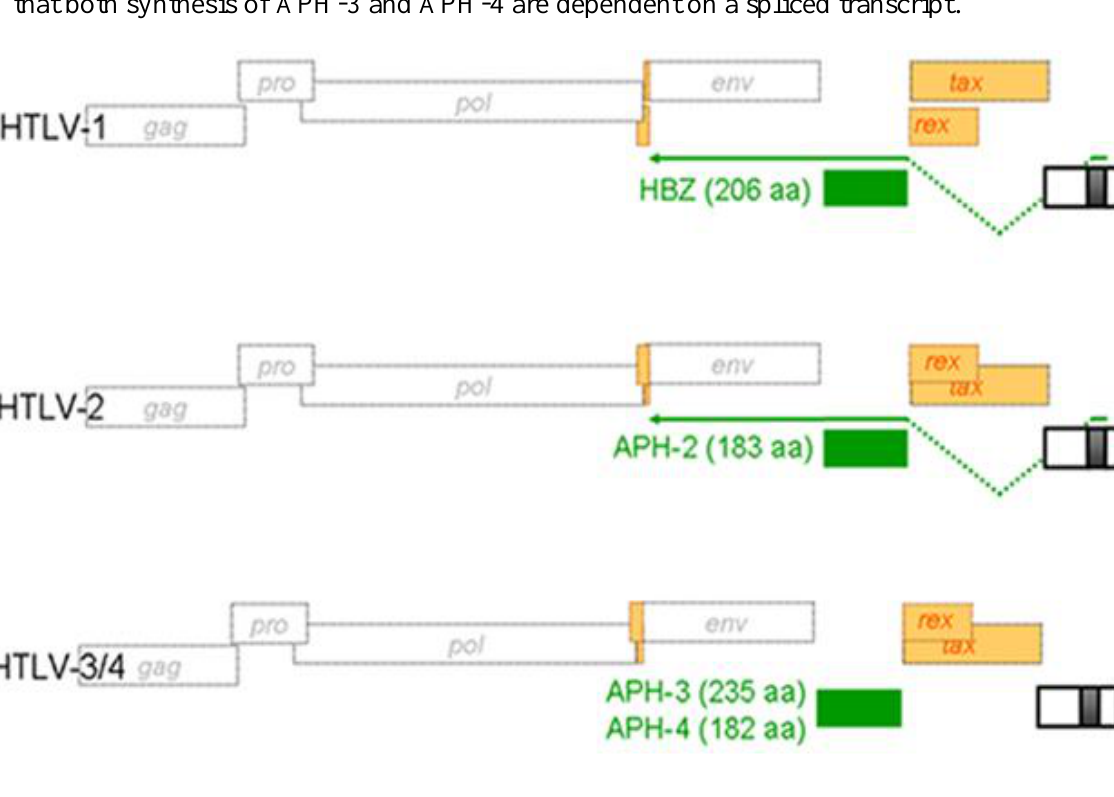
Figure 4. Schematic representation of antisense open reading frame (ORF) in other HTLV proviral genomes. Positioning of antisense transcript-encoded proteins termed APH in HTLV-2, HTLV-3 and HTLV-4 is similar to HBZ in HTLV-1. These proteins do